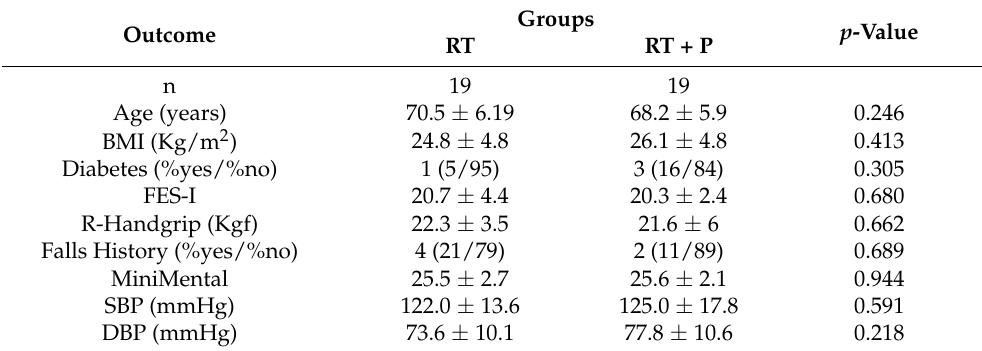
Table 3. Participants’ characteristics.